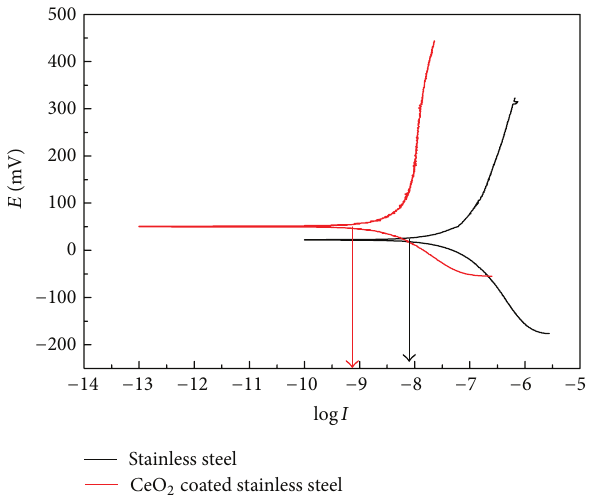
Figure 11: Tafel plots in 0.1M NaCl